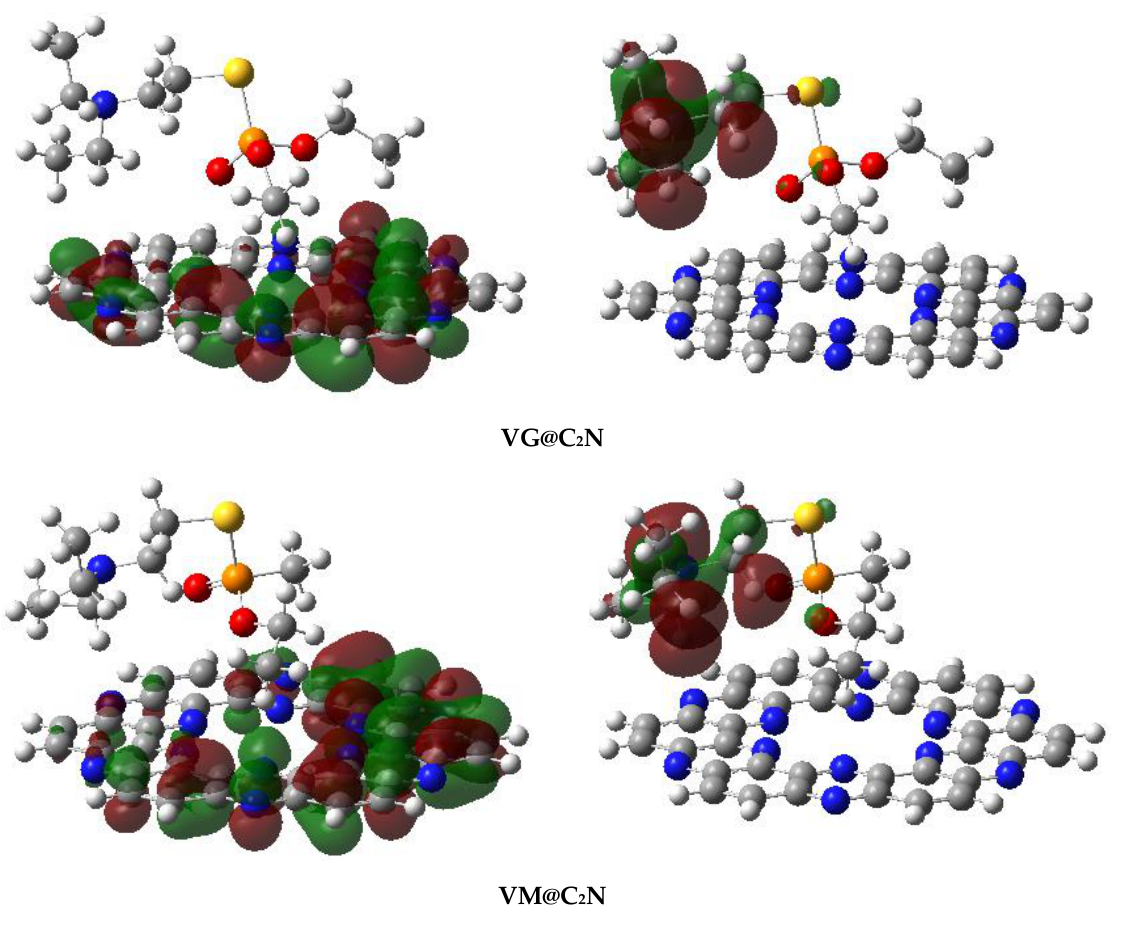
Figure 9. HOMO-LUMO densities of the studied V-series@C 2 N surface.